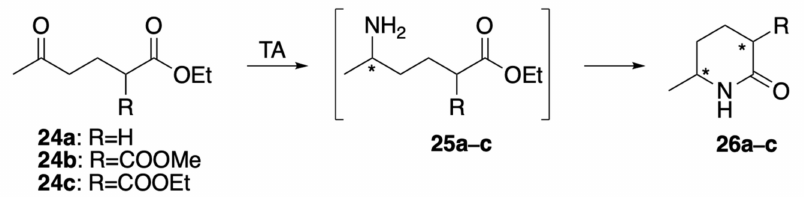
Figure 5. Transaminase-mediated synthesis of piperidone derivatives from keto